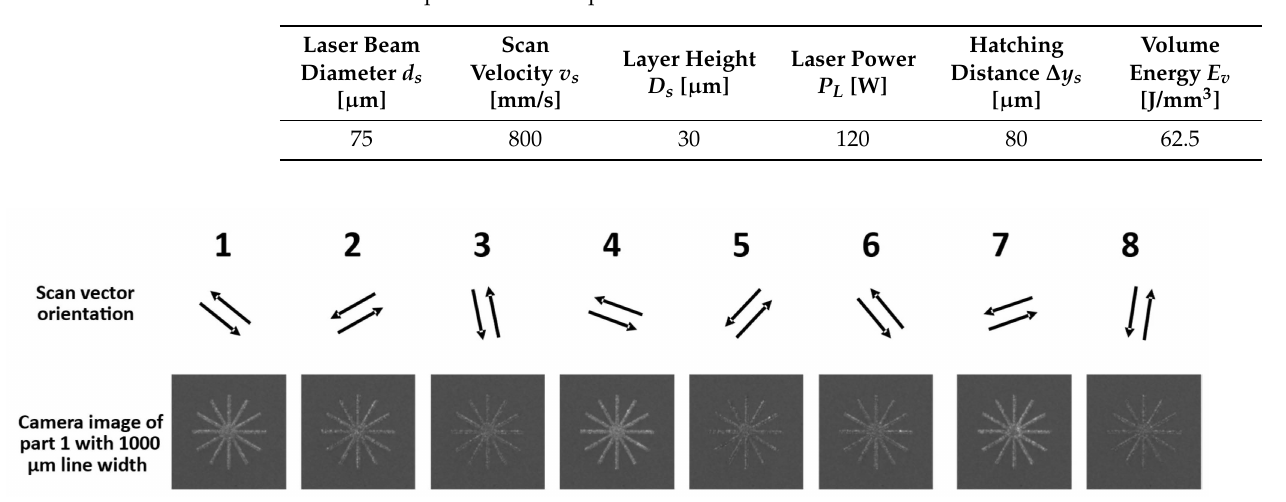
Figure 3. Different scan vector orientations and corresponding optical camera images. Captured monitoring images were cropped partwise according to the center position of parts to evaluate the location dependency. Every cropped part had a resolution of 512 × 512 pixels, which includes the laser-exposed part in the center and powder bed surroundings (in Figure